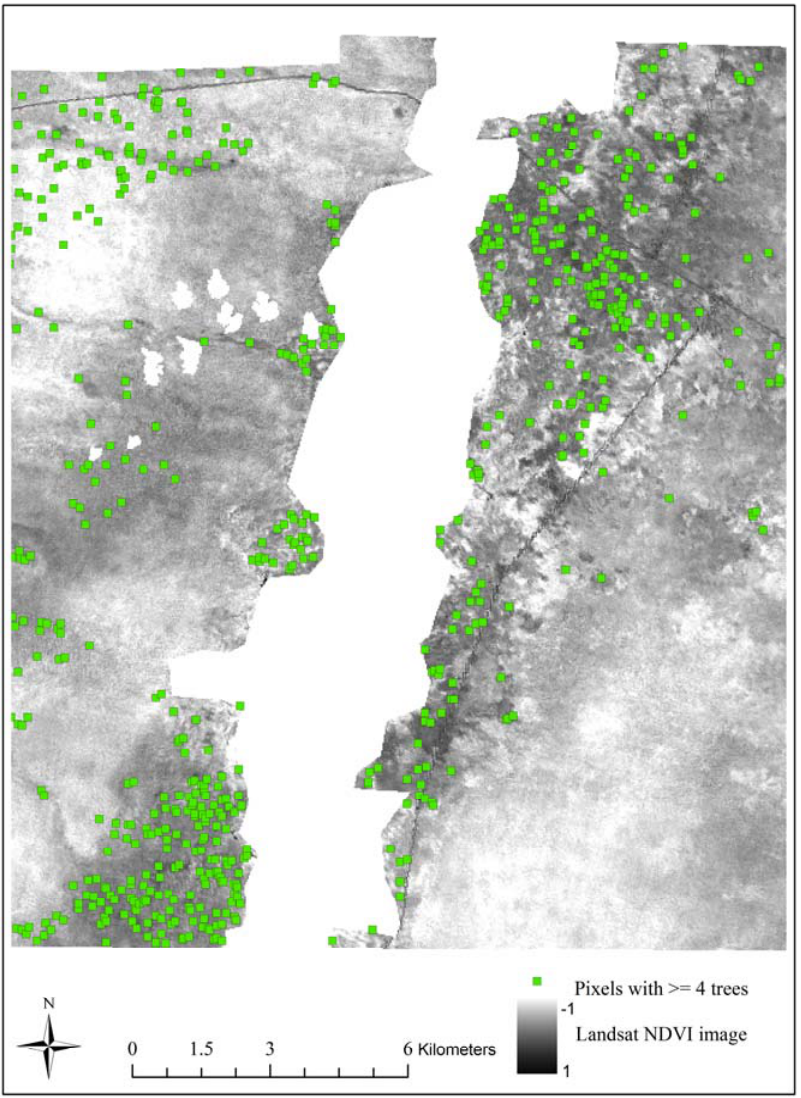
Figure 8. Spatial distribution of Landsat pixels with greater than four trees per 30 × 30 m